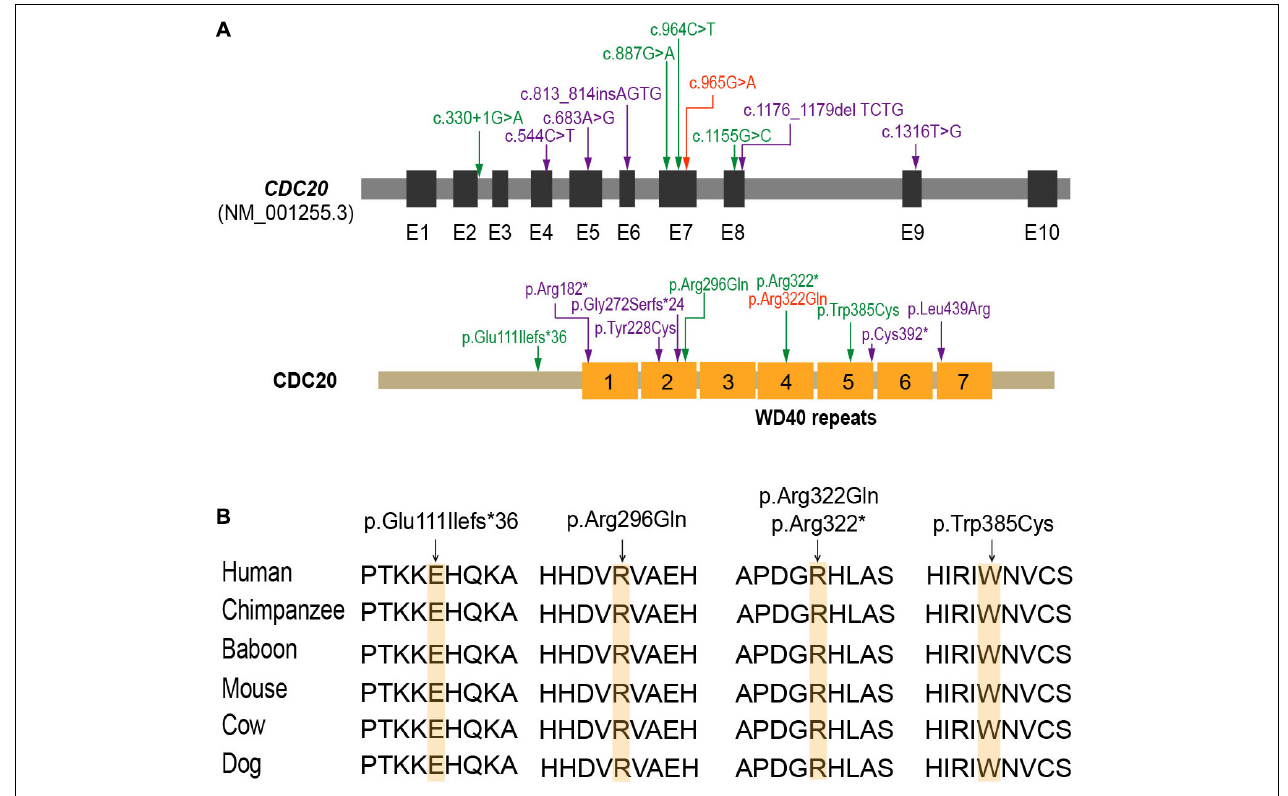
FIGURE 2 | The location and conservation analysis of altered residues in CDC20 . (A) The distribution of mutations in the CDC20 gene and protein structure. The mutations described in our previous study (Zhao et al., 2020b) are marked in purple, the novel mutations identified in this study are marked in green, and mutation c.965G > A (p.Arg322Gln), which was found in both this study and our previous study, is marked in orange. (B) Conservation of the altered residues is indicated by the alignment of six mammalian